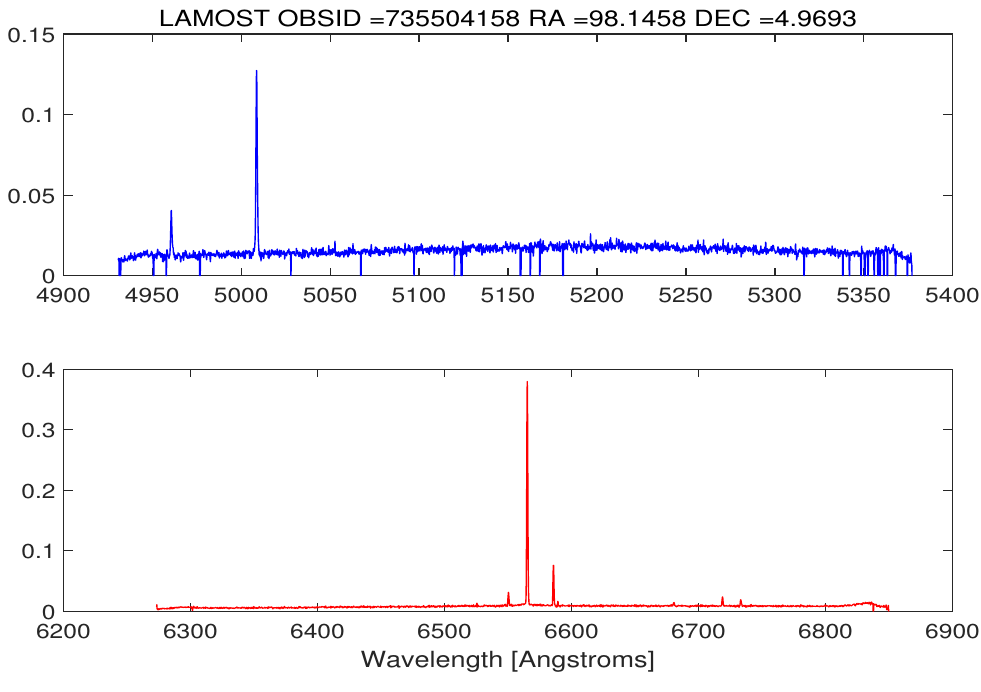
Figure 2. LAMOST MRS